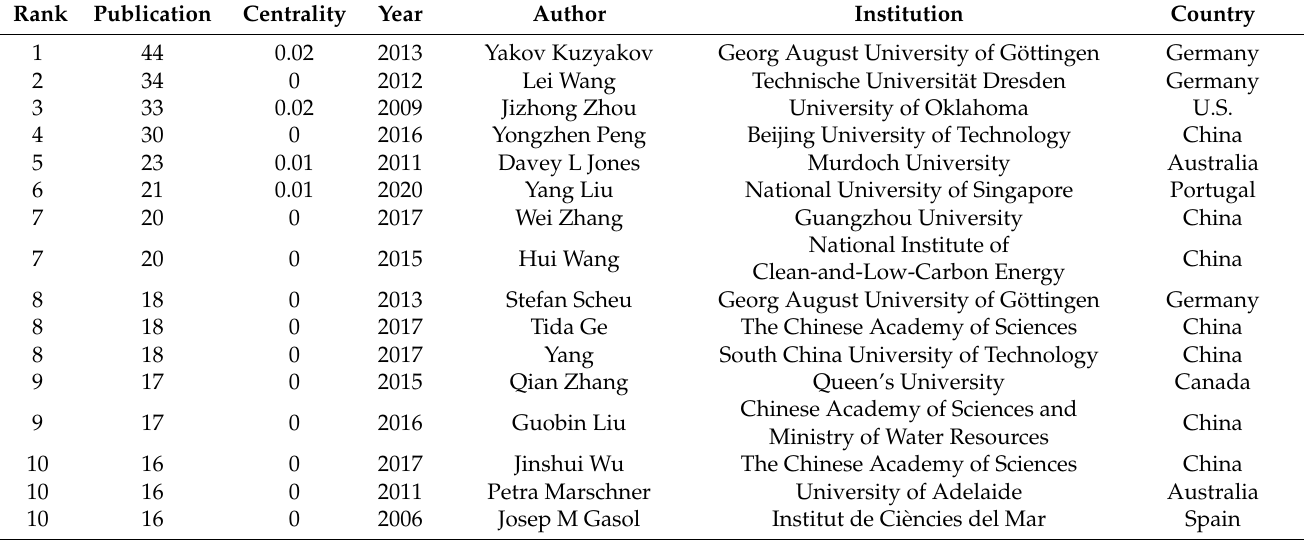
Table 5. Top 10 productive authors in the ZCC field during